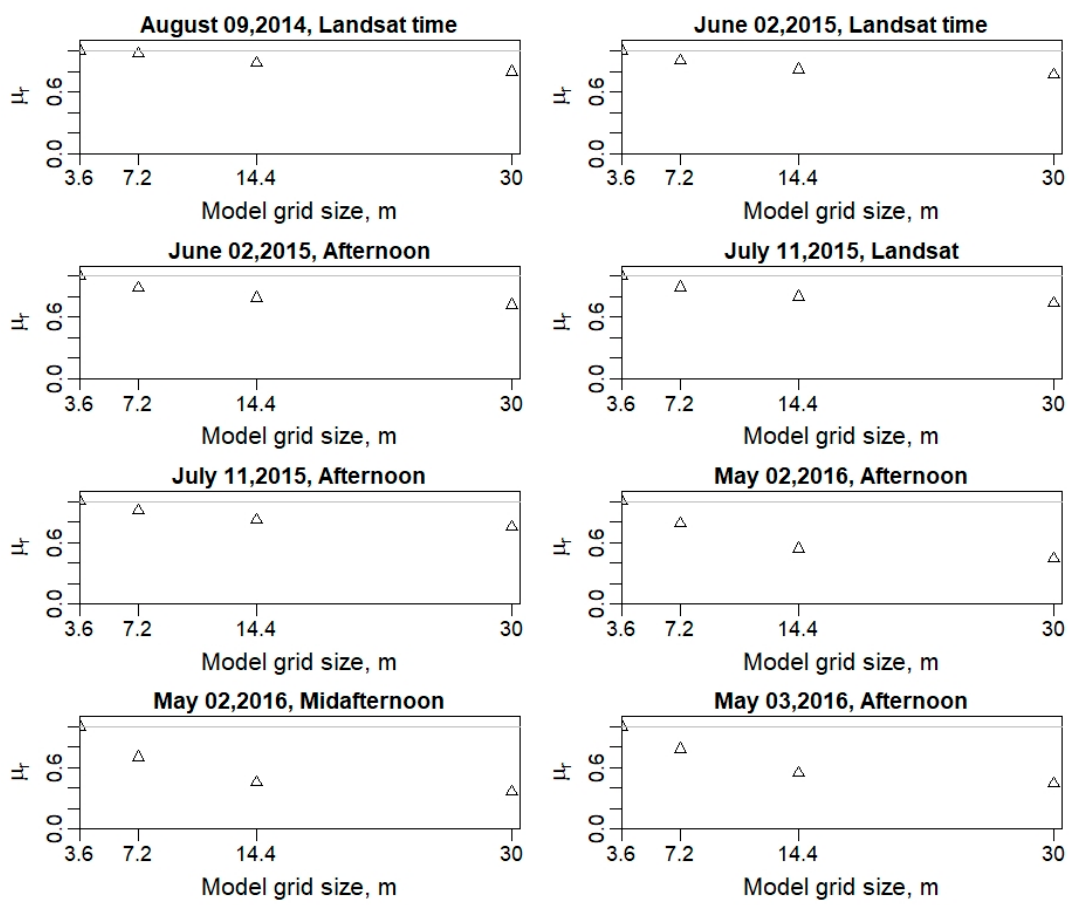
( µ r ) of R a for di ff erent